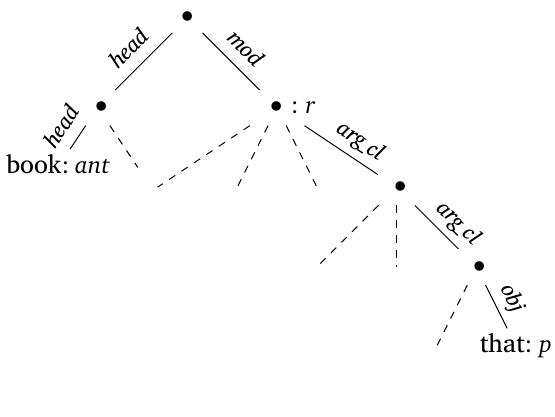
Linearization towards